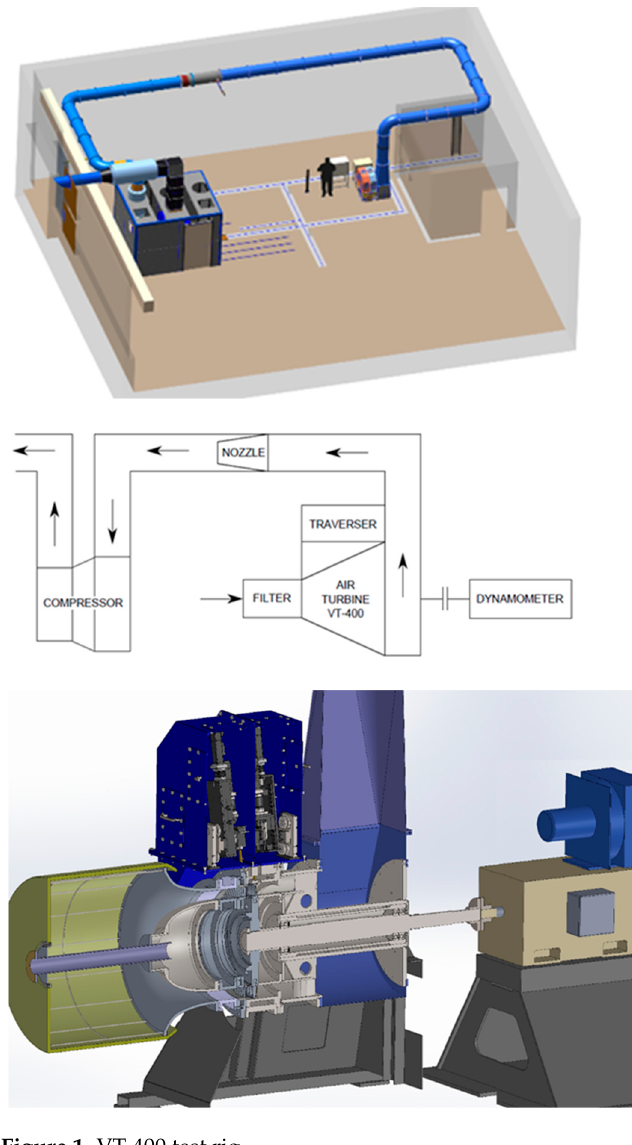
Figure 1. VT-400 test rig.